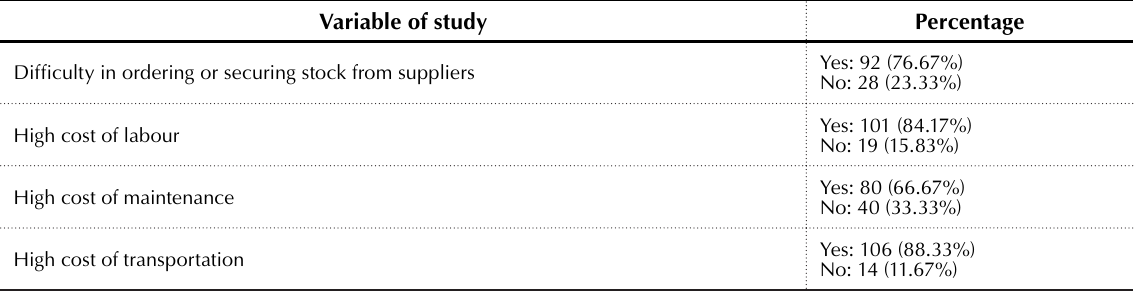
Table 2. Barriers to productivity (n = 120)